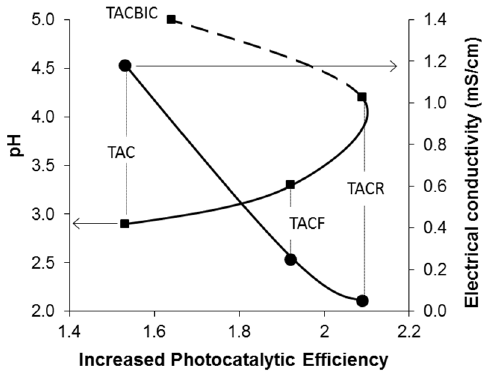
Figure 6. Increase in photocatalytic efficiency as a function of pH ( ▪ ) and electrical conductivity ( ● ).